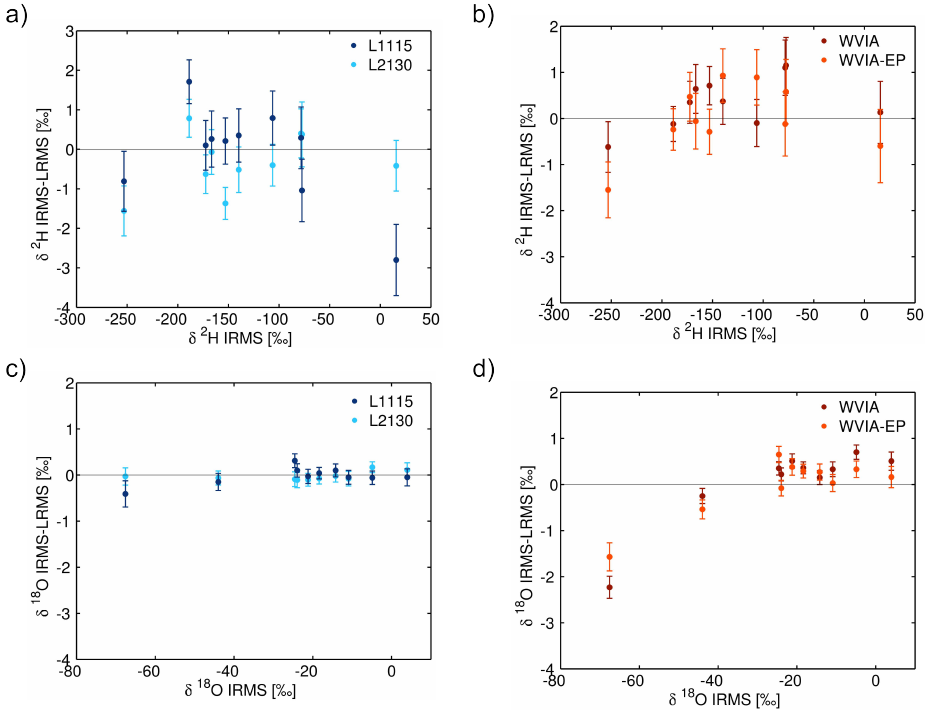
Fig. 2. Difference between the laser instrument measurements (LRMS) and IRMS for (a) δ 2 H of L1115-i and L2130-i, (b) δ 2 H of WVIA and WVIA-EP, (c) δ 18 O of L1115-i and L2130-i, (d) δ 18 O of WVIA and WVIA-EP measurements for the ten WS 1–10 (Table 2).